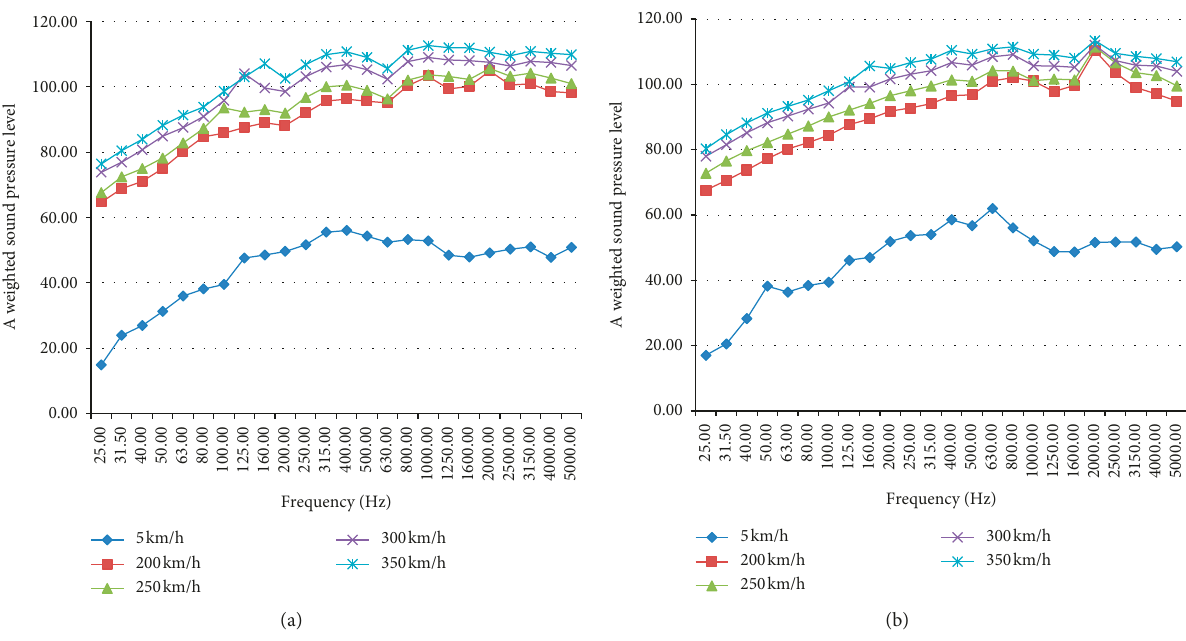
Figure 7: Noise sources at each speed. (a) Bogie area noise. (b) Wheel-rail noise of the 4th position.